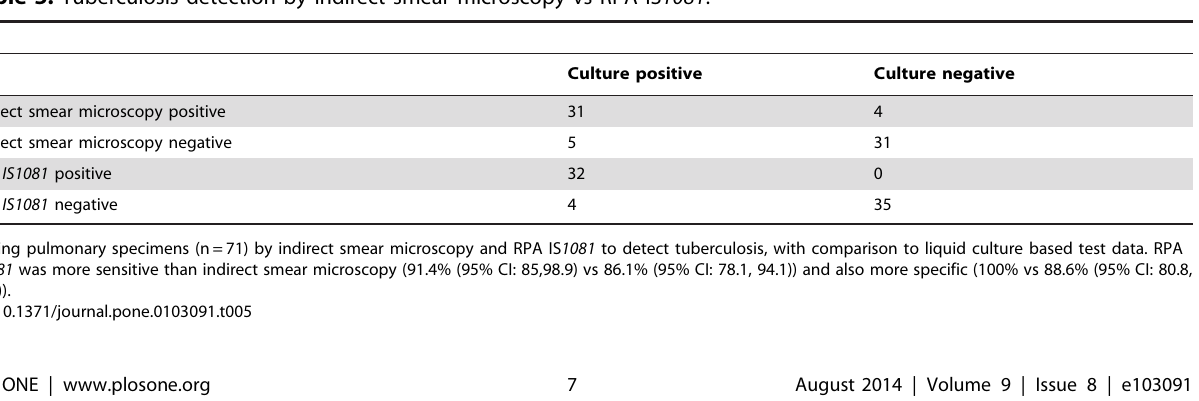
panel of 23 non tuberculous mycobacteria (NTMs) were tested (Table 1). Positive controls using 500 pg DNA from either M. bovis BCG or M. tuberculosis H37Rv were used for each batch.